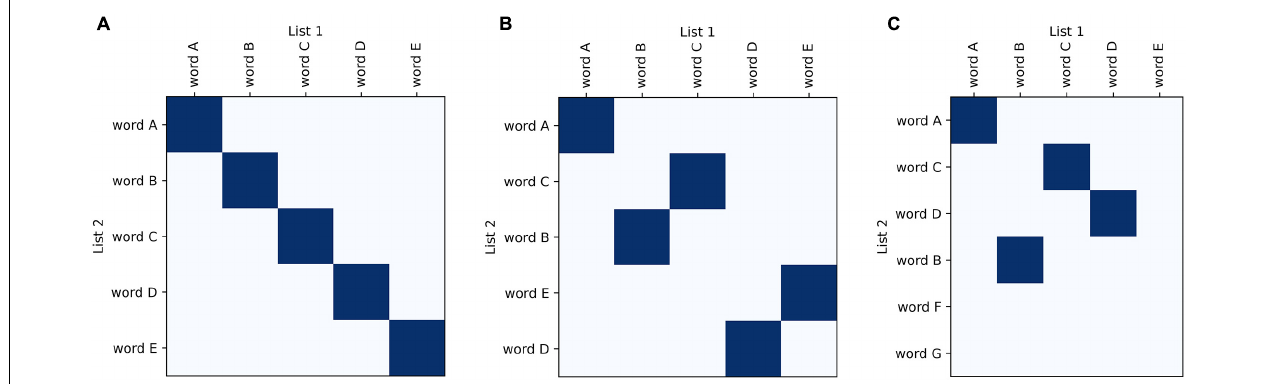
FIGURE 1 | Basic features of recurrence plots. Basic visualization principles for recurrence plots of recall data: one sequence of words is plotted along one axis and another along the other axis; areas of similarity are shaded using dark blue points. In semantic fluency the two lists compared could be taken from two different time points when the task was performed to track progress, whereas for list learning the lists would be the actual list compared to the participant’s recalled sequence. Identical lists fill the diagonal (A) , whereas lists that are increasingly different look more scattered (B,C) .